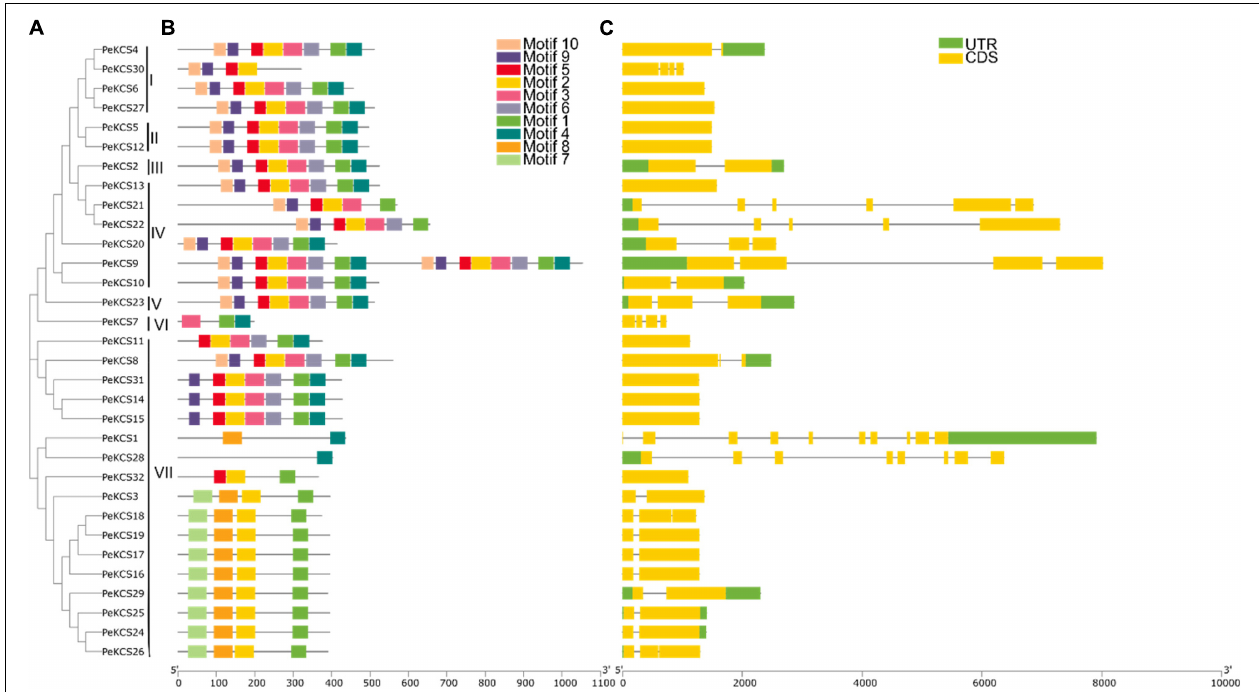
FIGURE 3 | The unrooted phylogenetic tree, conserved motifs and gene structure of PeKCS genes. (A) The neighbor-joining tree on the left comprised of 32 KCS proteins from passion fruit. (B) Conserved motifs were represented via boxes and different colors represents different motifs. (C) PeKCS genes structures, yellow color indicates the exons, the green color shows the untranslated 5 (cid:48) and 3 (cid:48) -regions, and gray color indicates the introns.